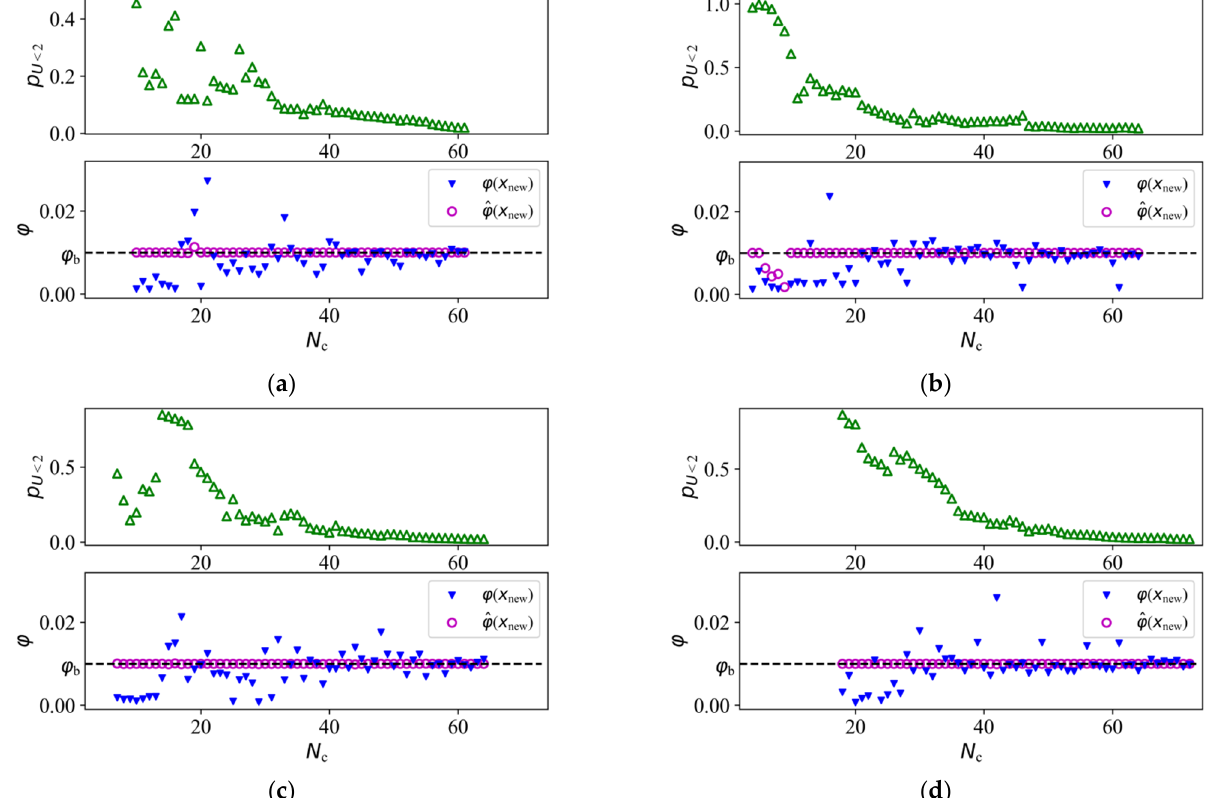
I = 9. ( b ) N I = 3. ( c ) N I = 6.